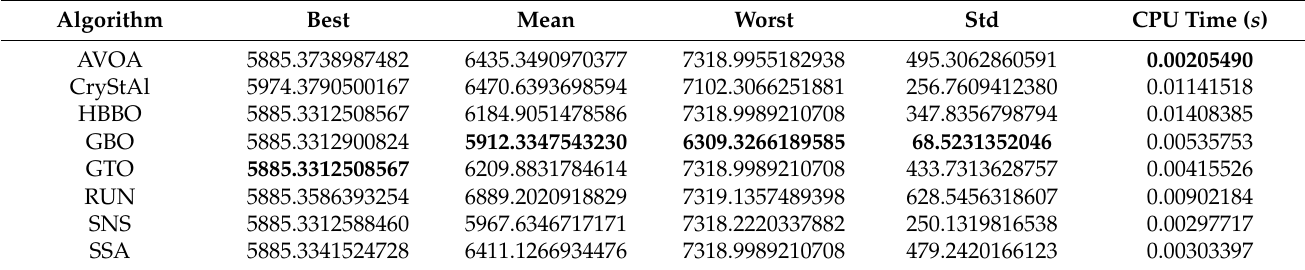
Table 10. Statistical findings of the bench-marked algorithms for the cylindrical pressure vessel design problem.